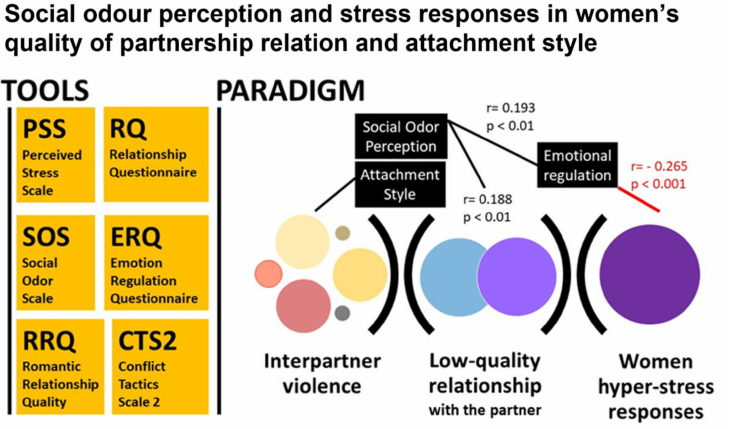
Figure 2. Integrative Map of the role of social odour perception as a modulator of women’s stress responses in the quality of the partner relationship and attachment style, as found in Figure 1 and Table